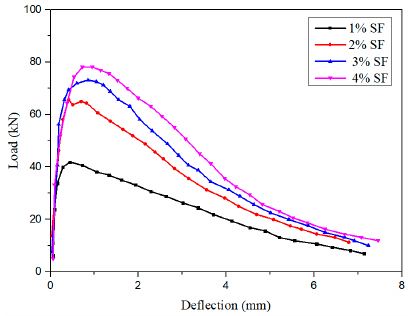
Figure 17. Effects of the SFs content on the load–deflection curve [86].